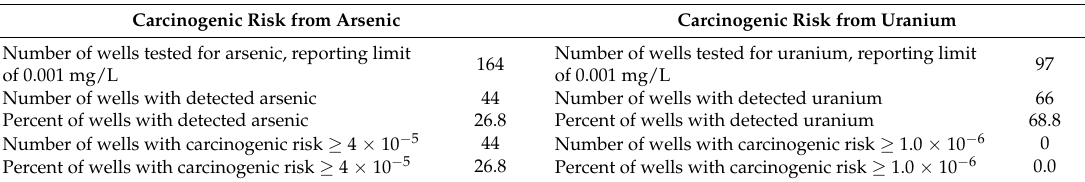
Table 9. Comparison of summary statistics for: health risk as measured by hazard indices (HIs) vs. well water quality as measured by the sum of risk quotients